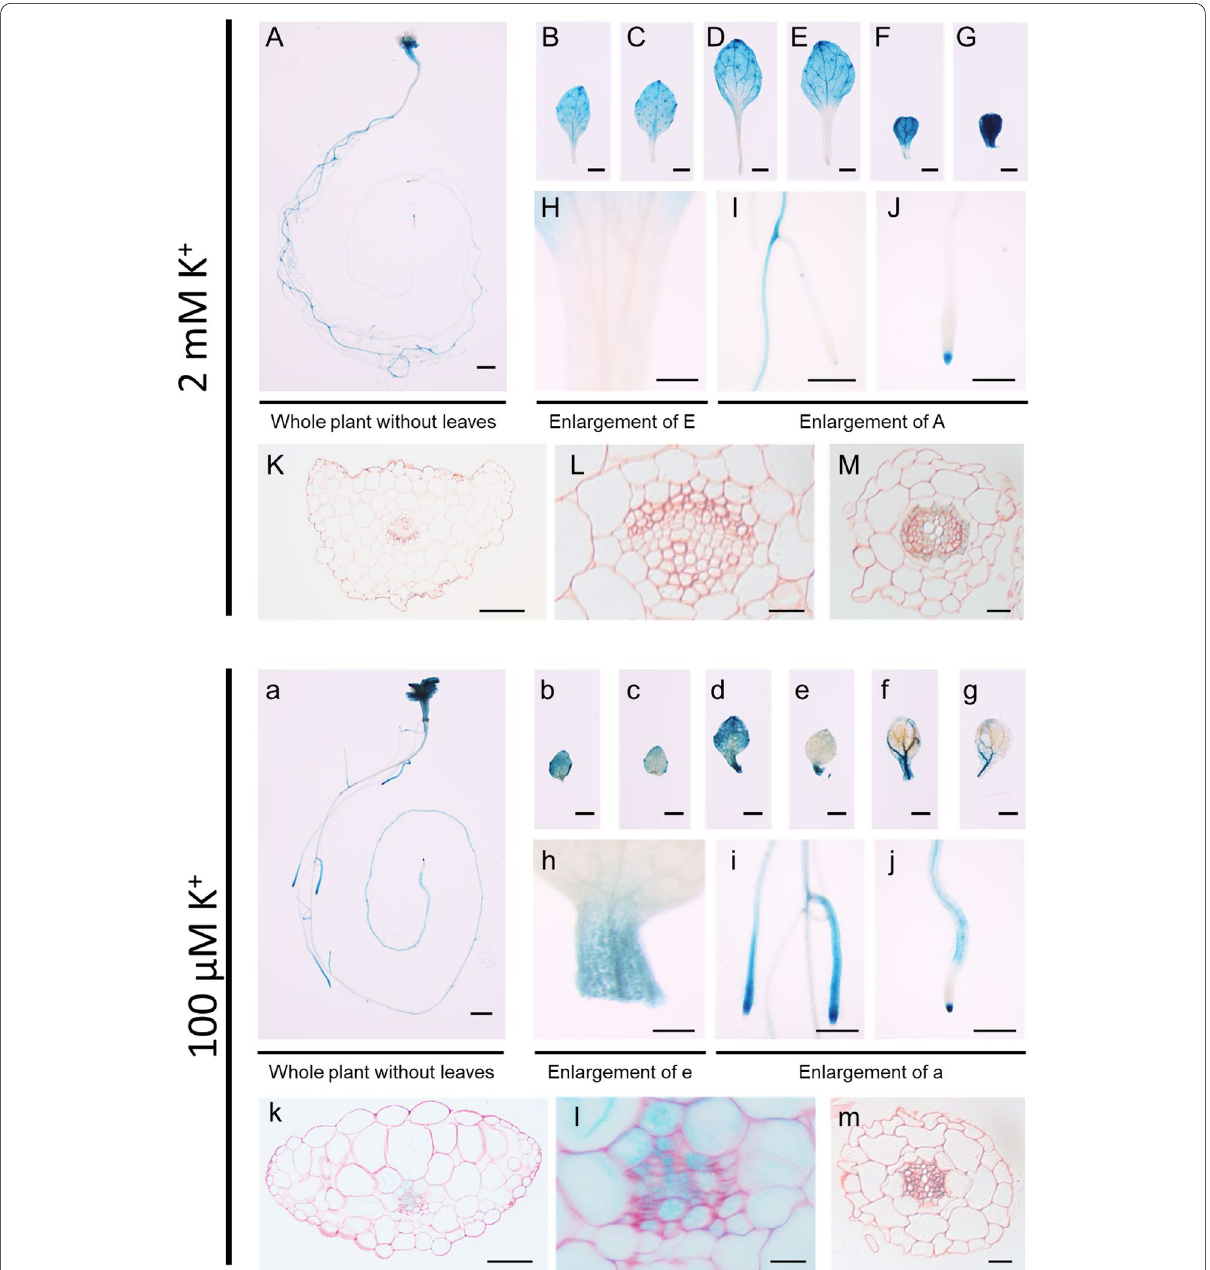
Fig. 3 GUS reporter assay of KUP9 promoter activity in Arabidopsis. GUS staining of two-week-old seedlings containing a KUP9 promoter-GUS construct grown in medium containing 2 mM K + (A-M) or l00 μM K + (a-m). Whole plant without leaves (A, a), 5th or 6th leaf (B, C, b and c), 3rd or 4th leaf (D, E, d and e), 1st or 2nd leaf (F, G, f and g), petioles (H, h), lateral and primary roots (I, i), and root tip (J, j). Cross-sections of petioles (K, L, k and l) and roots (M and m). L and l are enlarged from K and k. Scale bars represent 1 mm in (A-G and a-g), 0.5 mm in (H-J and h-j), 100 μm in (K, and k) and 20 μm in (L and M, l and